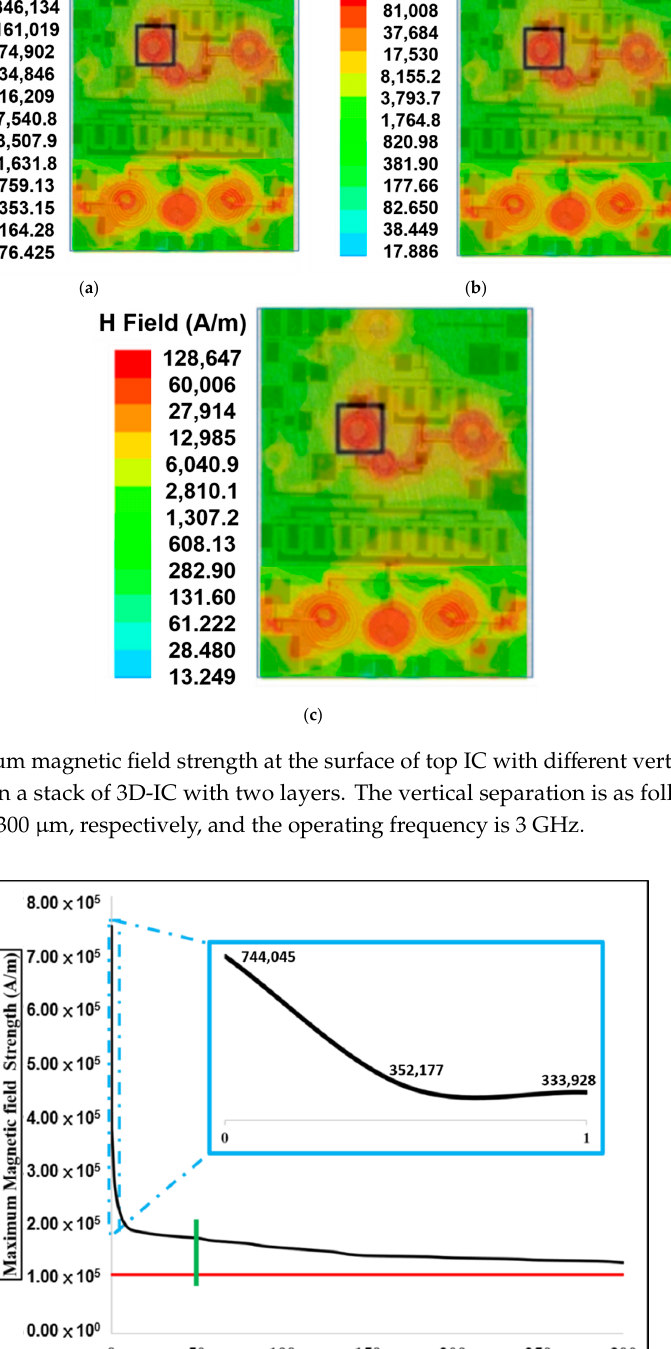
Figure 9. Hypothetical 3D-IC layout in HFSS: ( a ) two layers in stack of 3D-IC (2D-3D-IC) and ( b ) three layers in stack of 3D-IC (3D-3D-IC).